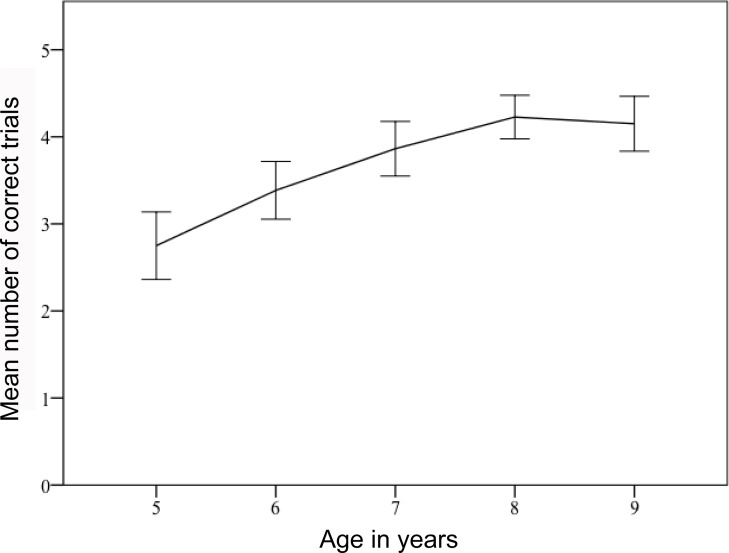
Mean number of correct trials across all 5 trials for all conditions by age (in years).Success rate increased significantly with age. Error bars indicate standard errors.